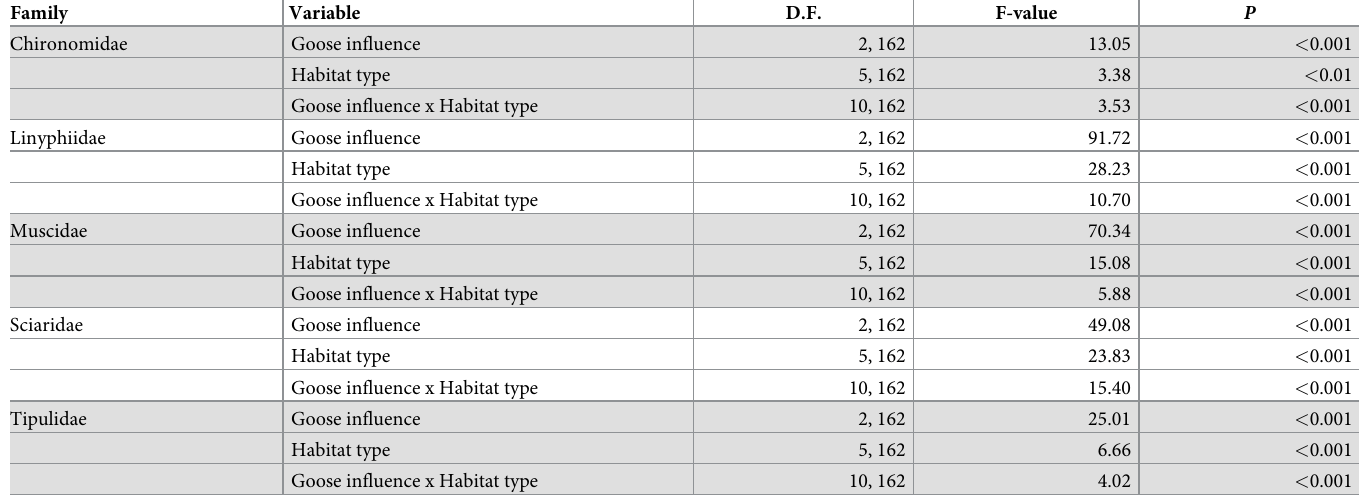
Table 1. Results of post-hoc ANOVAs testing the effects of site, habitat type, and a site by habitat type interaction on the abundances of the dominant five inverte- brate families collected in pitfall traps situated at a gradient of goose